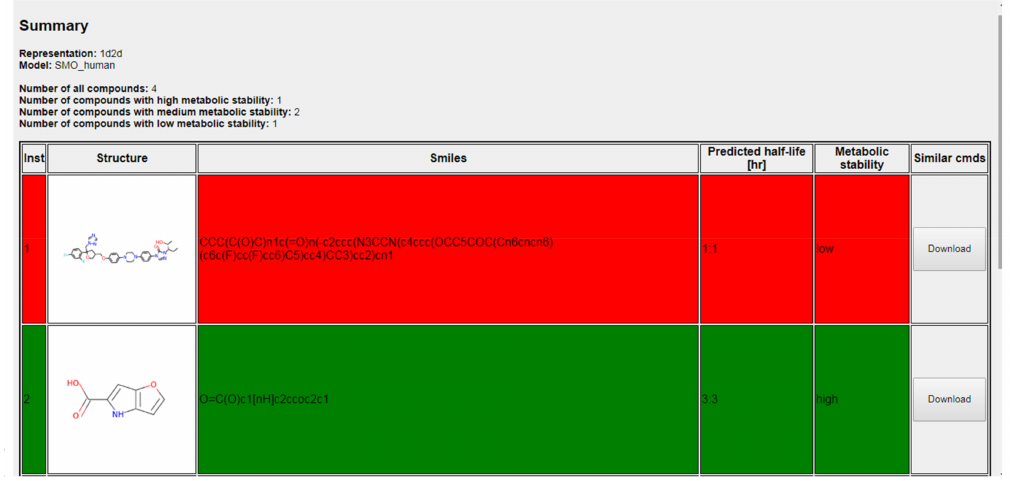
Figure 8. Screenshot from example results, containing summary of predictions and predicted metabolic stabilities with coloring corresponding to metabolic stability